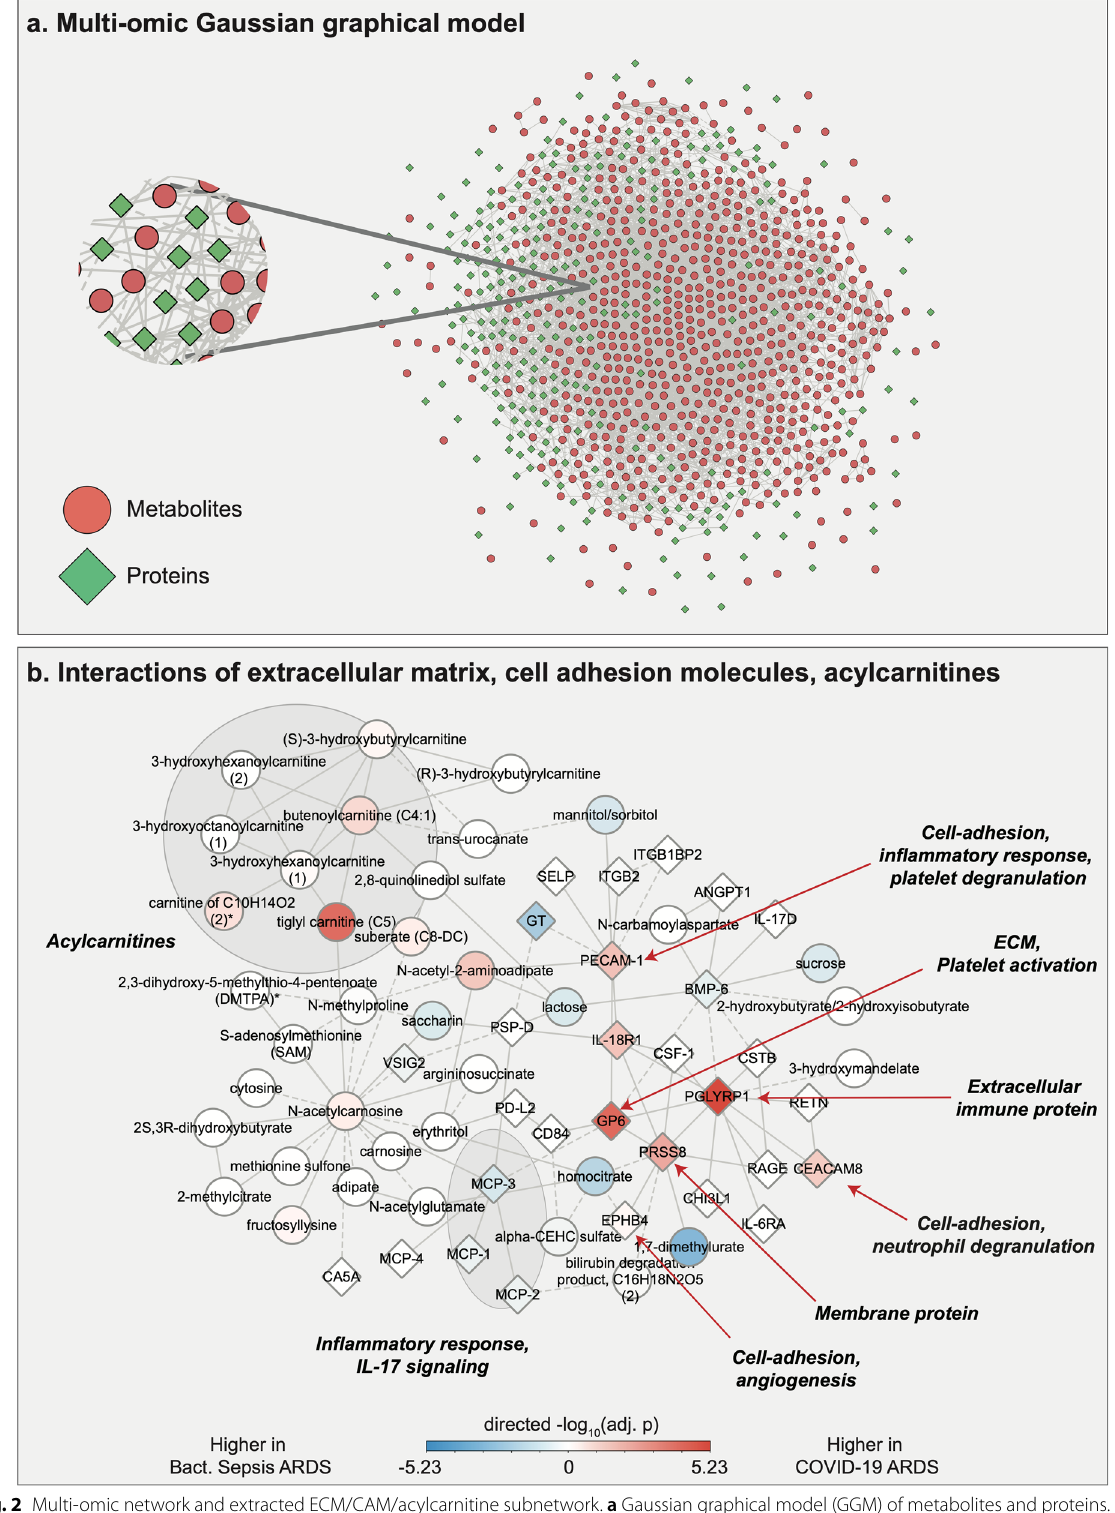
Fig. 2 Multi‑omic network and extracted ECM/CAM/acylcarnitine subnetwork. a Gaussian graphical model (GGM) of metabolites and proteins. Shapes and colors of the molecules in the network are based on the two omics types. b Subnetwork extracted from the full multi‑omic GGM, built around tiglyl carnitine and GP6. The observed molecular interactions suggest an interplay of ECM derangement, inflammation, and mitochondrial dysfunction in ARDS